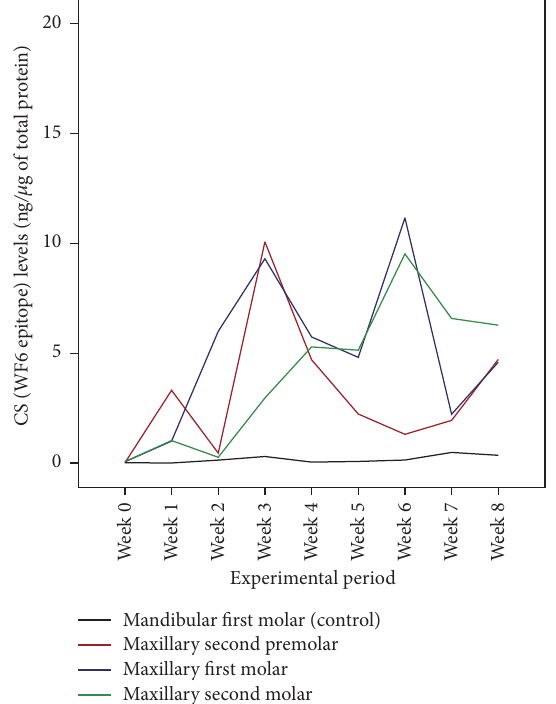
Figure 8: A profile graph of the CS levels in a subject during the unloaded period (week 0) and the loaded periods (week 1 to week